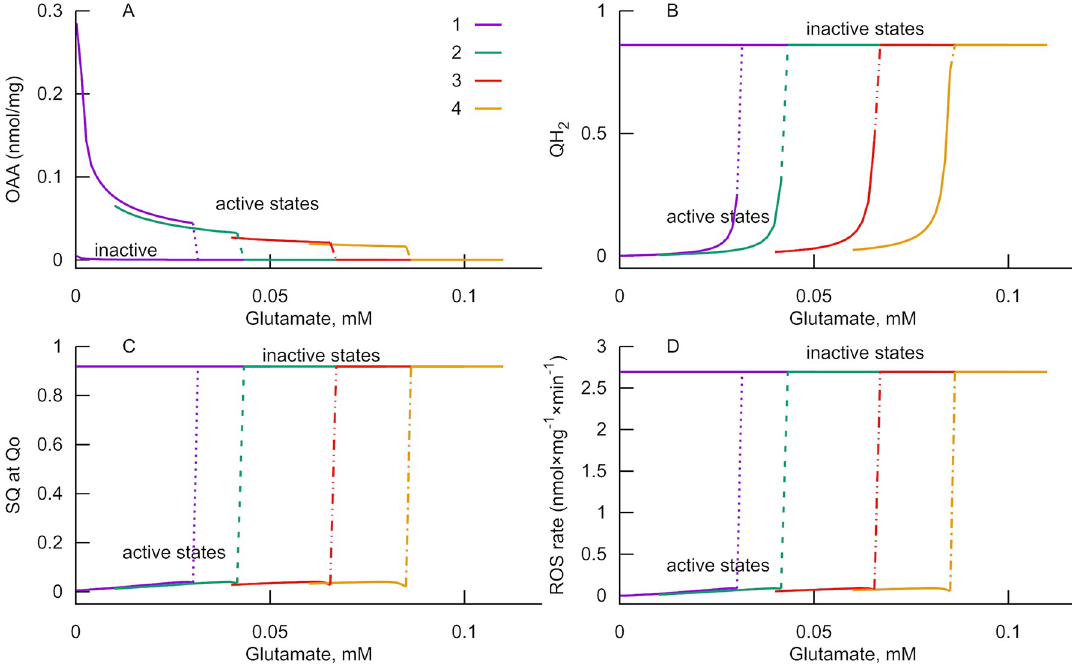
Fig 3. Stepwise activation of ROS generation by glutamate. Gradual increase of glutamate concentration leads to abrupt changes (bifurcation) in the RC state (indicated by dotted and dashed lines). Mitochondrial oxaloacetate concentration decreases (A). Free ubiquinone becomes practically completely reduced (B, QH 2 ratio to the total ubiquinone amount is shown). The fraction of semiquinone (SQ) formed at the Qo site of complex III increases (C). ROS generation in complexes II and III increases (D, the ratio of ROS accumulated during the first minute to the amount of these complexes is shown). The maximal rate of ROS generation corresponds to that obtained experimentally when the rate constant of ROS formation is 2 × 10 − 5 s -1 . Curves 1–4 are obtained with different values of rate constant of FAD reduction by succinate in the flavin center of complex II (in (nmol/mg) -1 s -1 ), 1: 175, 2: 131, 3: 88, 4: